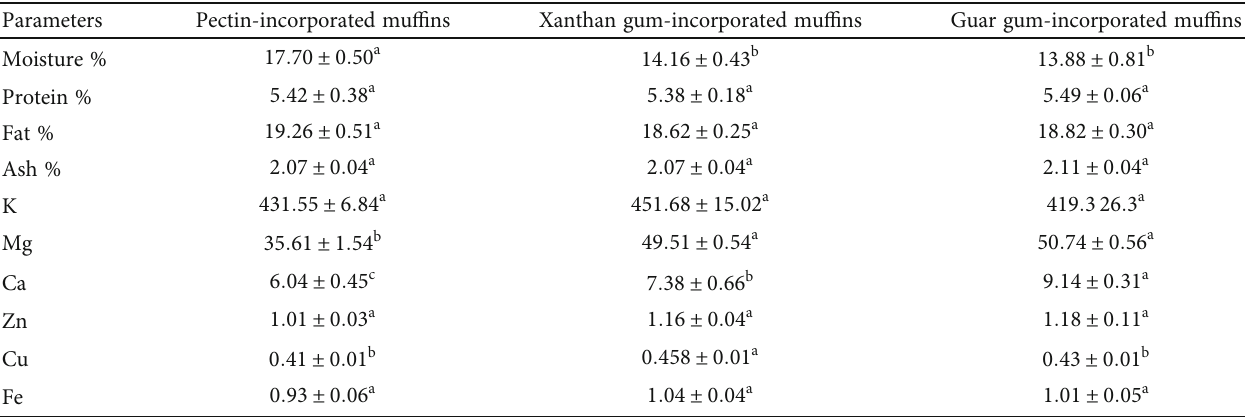
Figure 2: D. alata fl our mu ffi ns. (a) Pectin-incorporated mu ffi ns. (b) Xanthan gum-incorporated mu ffi ns. (c) Guar gum-incorporated mu ffi ns. Table 1: Nutritional composition of three di ff erent mu ffi